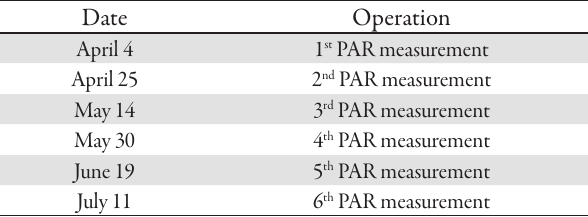
Tab. 2. Dates of PAR interception measurement